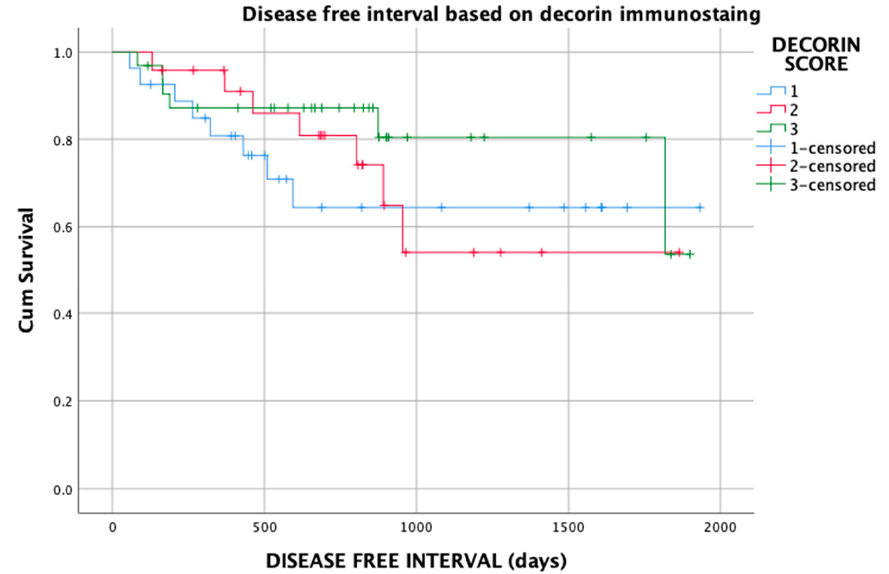
Figure 6. Kaplan–Meier graph of disease-free interval for 83 patients with soft tissue sarcoma based on decorin immunostaining pa tt ern (types 1, 2 and 3).